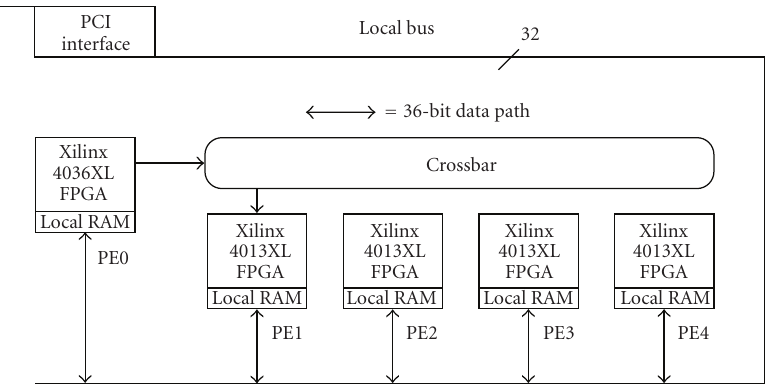
Figure 2: Wildforce-XL as used in the CHAMPION